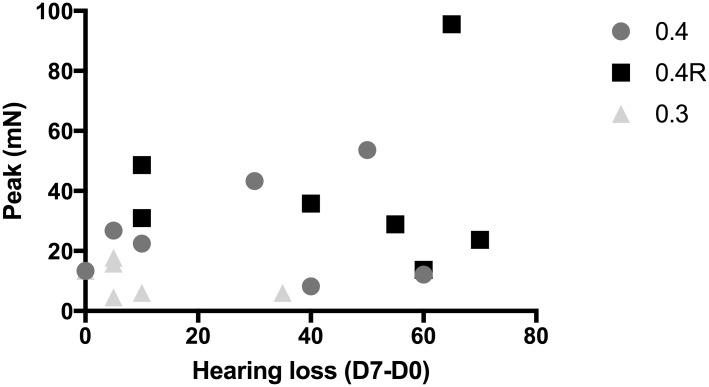
Correlation between hearing loss (dB) at 16000 Hz on D7 and maximal peak force measured during insertion of the three types of electrode array.0.4R (black squares) (n = 7), 0.4 (dark grey circles) (n = 7), and 0.3 (light grey triangles) (n = 6) electrode arrays. Linear regression, respectively: Y = 0.31X + 17.2, Y (mN), X (dB), n = 20, R = 0.13, slope not different from 0, p = 0.12.